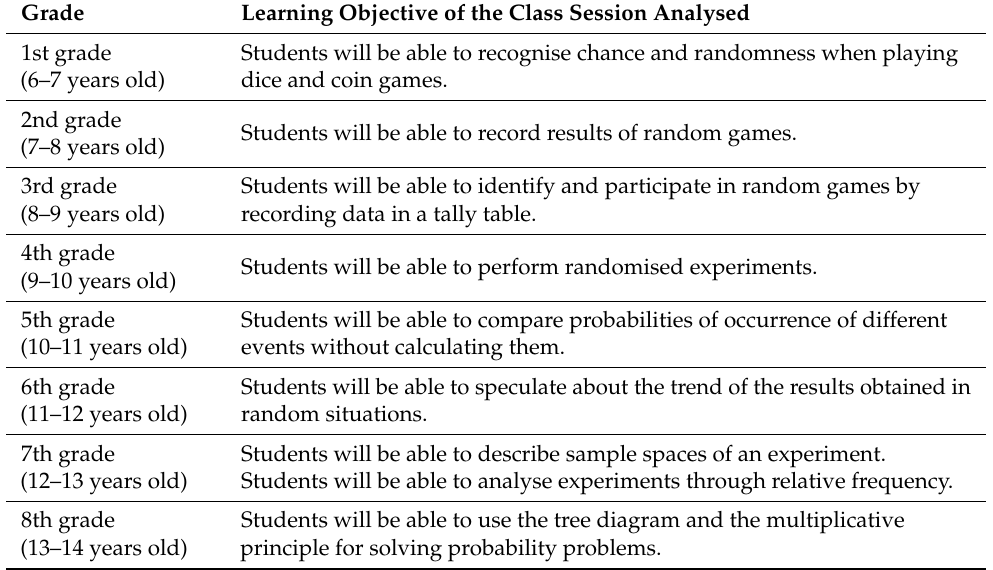
Table 2. Characterisation of the class sessions analysed.